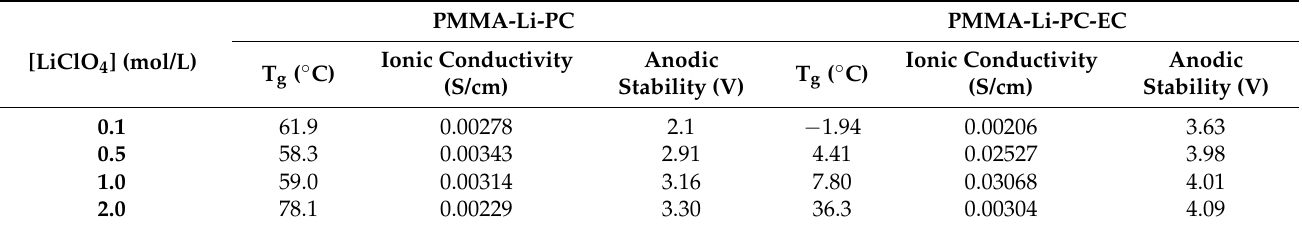
Table 4. Summary of the main results shown above for PMMA-Li-PC and PMMA-Li-PC-EC poly- meric gel electrolytes at different salt concentrations: 0.1 M, 0.5 M, 1 M and 2 M: glass transition temperatures (T g ), Ionic Conductivity and Anodic